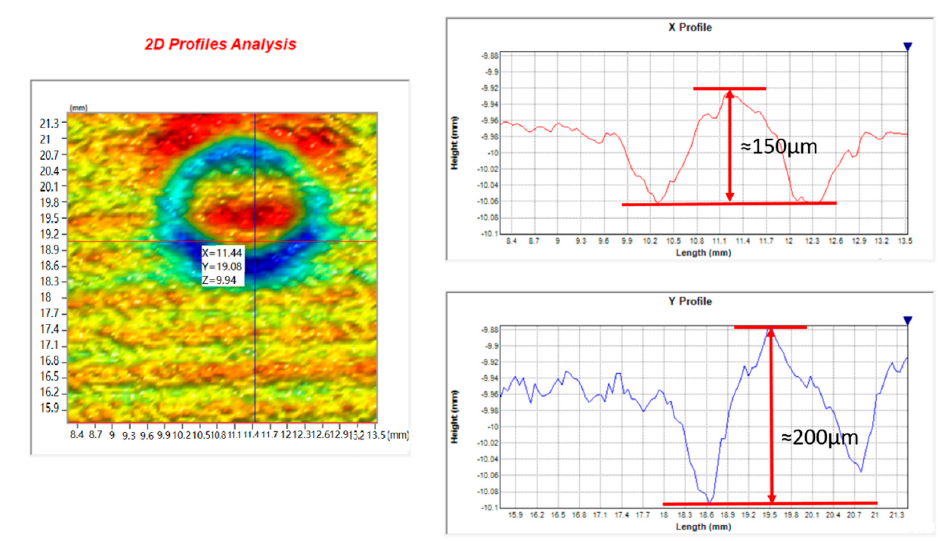
Figure 13. The 2D profile of the measurement error because of the ring effect.